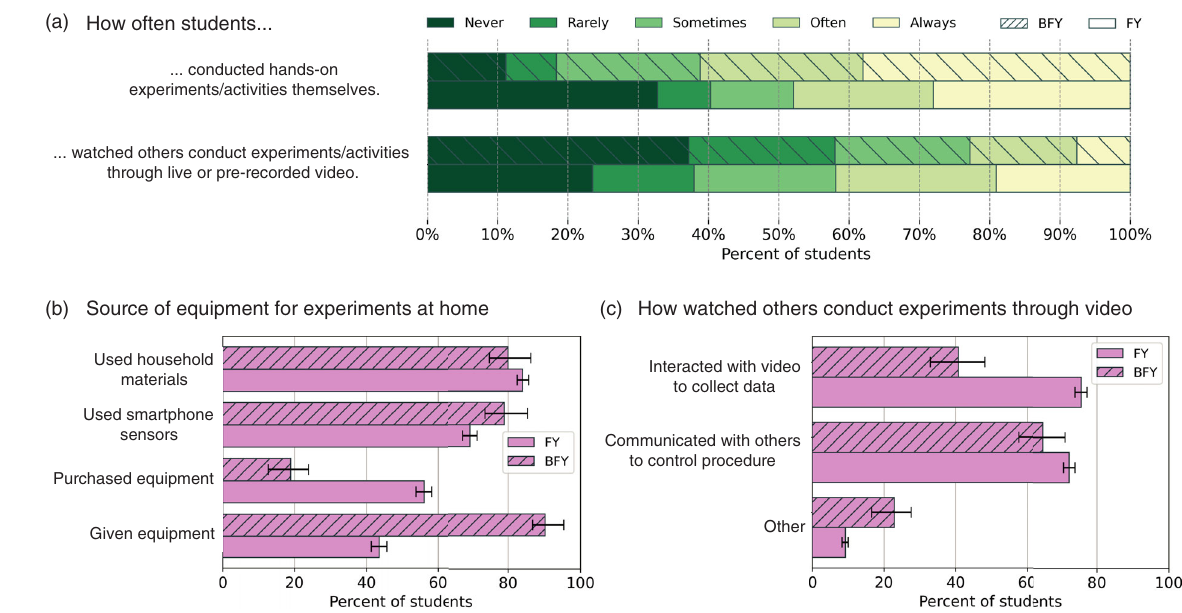
FIG. 2. Student experiences with conducting hands-on experiments themselves and watching others conduct experiments over video. (a) Percent of students in FY (plain, N ¼ 4565 ) and BFY (hatched, N ¼ 250 ) courses who never, rarely, sometimes, often, and always (progressively lighter shades of green) conducted hands-on experiments and watched others conduct experiments over video. (b) Percent of students in FY (plain, N ¼ 1963 ) and BFY (hatched, N ¼ 185 ) courses who used different kinds of equipment for hands-on experiments at home out of the students who completed hands-on experiments at home. (c) Percent of students in FY (plain, N ¼ 3491 ) and BFY (hatched, N ¼ 157 ) courses who engaged with videos in different ways out of the students who watched others conduct experiments over video with any